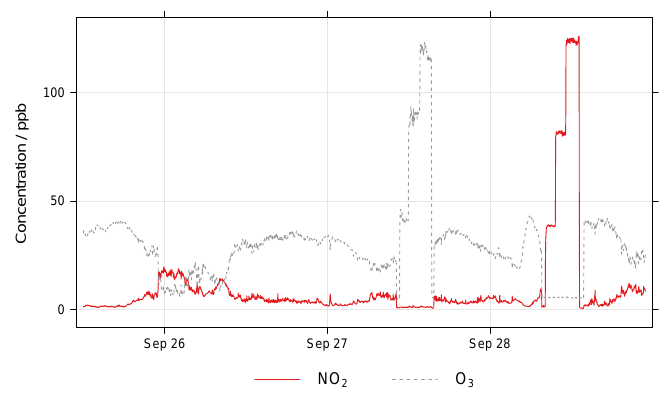
Figure 9. Example concentration profile from EC calibration in the EASE